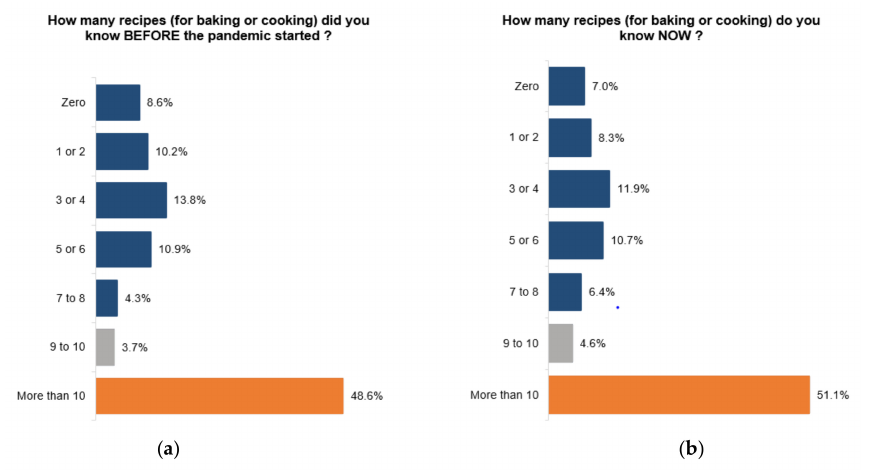
Figure 3. ( a ) Number of known recipes before pandemic, ( b ) Recipes known now.